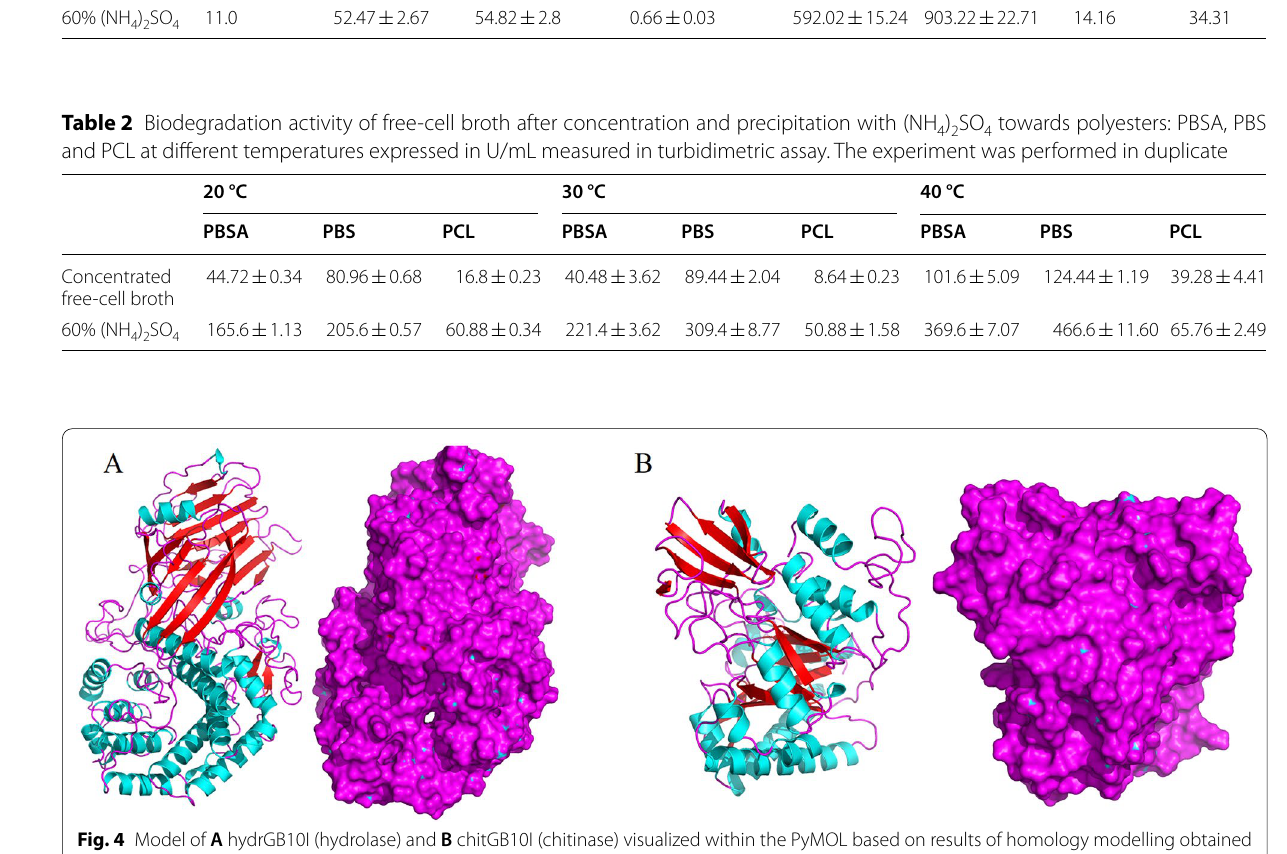
Table 1 Purification of native enzymes from the cell-free broth of Geomyces sp. B10I. The activity was measured in a turbidimetric assay with PBSA as a substrate for enzyme activity. Unsuccessfully, it was not possible to determine the activity of purified enzymes after the IEC procedure. The assays were performed in duplicate Volume (mL) Protein (µg/mL) Activity (U/mL) Total protein (mg) Free-cell broth 350.0